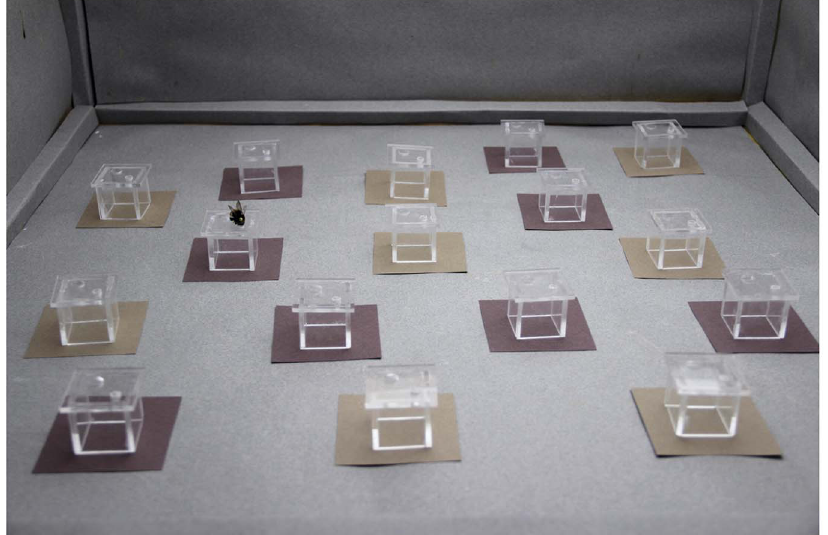
Figure 2. Flight arena used in this study. Photograph showing how stimuli were presented in association with the artificial flowers and distributed throughout the flight arena, as well as a marked bumblebee (marked with a numbered yellow tag) visiting a